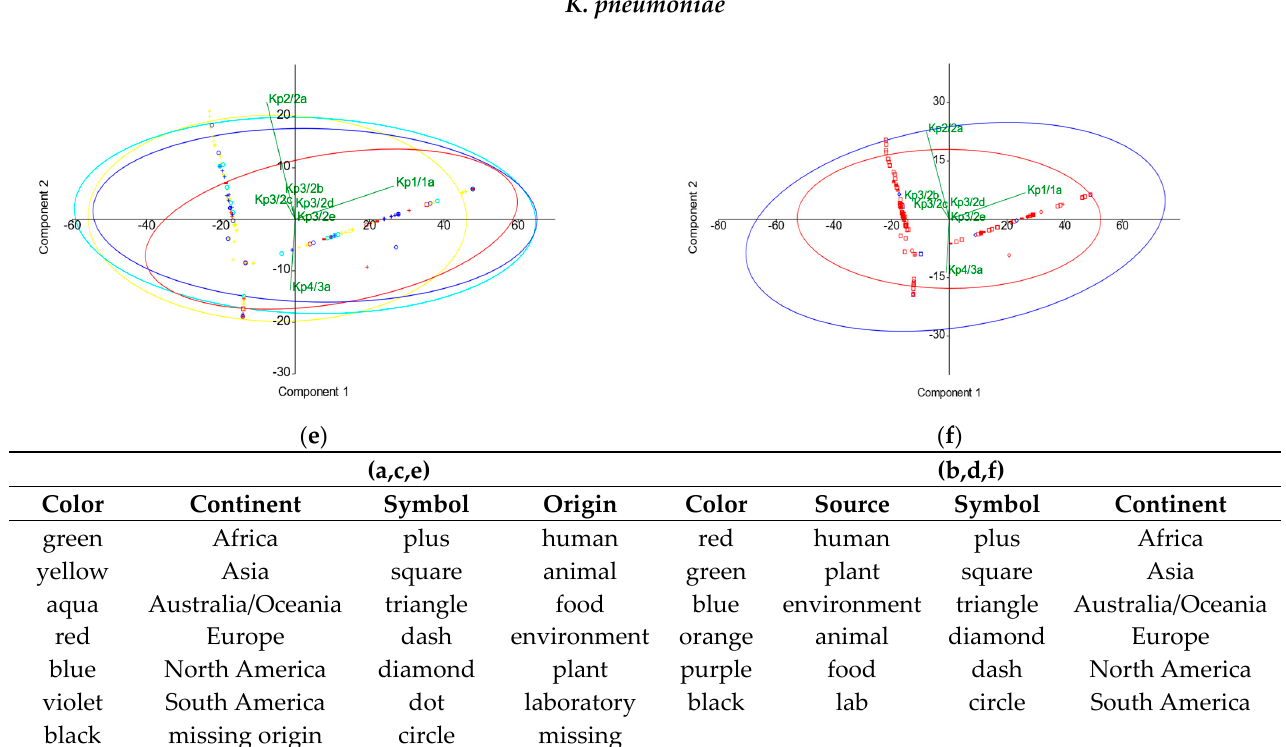
Figure 5. PCA analysis by ( a , c , e ) geographical origin and ( b , d , f ) isolation source types.